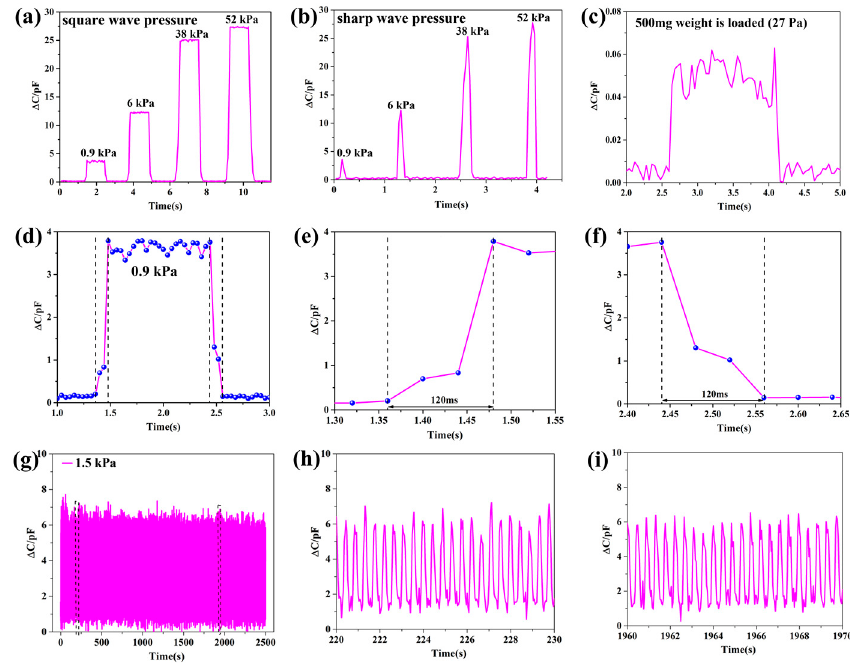
Figure 10. Dynamic performance of the capacitive pressure sensors. ( a ) The output curve under the square wave pressure of 0.9 kPa, 6 kPa, 38 kPa, and 52 kPa; ( b ) the output curve under the sharp wave pressure of 0.9 kPa, 6 kPa, 38 kPa, and 52 kPa; ( c ) minimum response curve of force for 27 Pa; ( d ) the sensor force response curves for 0.9 kPa; ( e ) response time of the sensor; ( f ) recovery time of the sensor; ( g ) repeatability curve of the sensor under the pressure of 1.5 kPa; ( h ) local repeatability curve within 220–230 s; ( i ) local repeatability curve within 1960–1970 s.